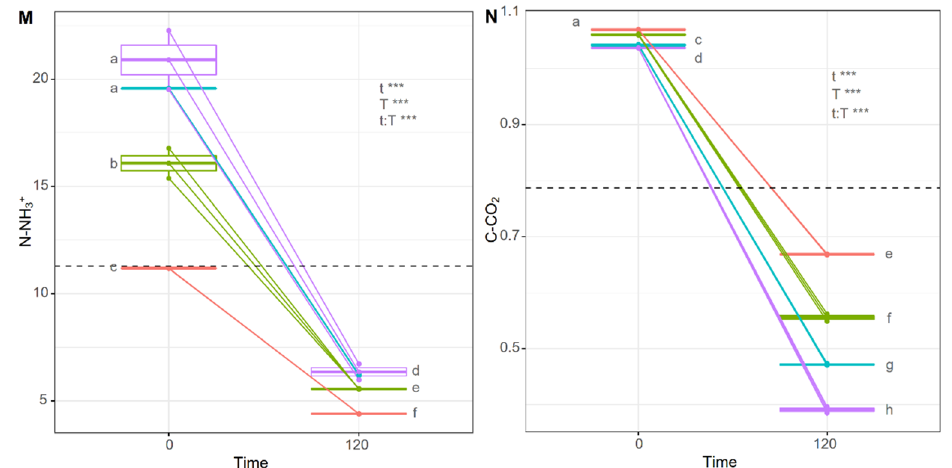
Figure 1. Two-way ANOVA of composting systems during C and N mineralization dynamics. Different letters indicate significant differences according to the two-way ANOVA with subsequent Tukey’s test of means at a significance level p ≤ 0.05. Time (days); T, treatment (T1, red line; T2, green line; T3, blue line; T4, purple line). ( A ) T , temperature (°C); ( B ) M, moisture (%); ( C ) pH, hydrogen potential; ( D ) EC, electrical conductivity (dS m − 1 ); ( E ) BD, bulk density (g cm − 3 ); ( F ) WHC, water holding capacity (%); ( G ) N-NO 2 − , nitrite (mg N-NO 2 − kg − 1 dry compost); ( H ) N-NO 3 − , nitrate (mg N-NO 3 − kg − 1 dry compost); ( I ) N-NH 4+ , ammonium (mg N-NH 4+ kg − 1 dry compost); ( J ) N min , mineralized N (mg N kg − 1 dry compost); ( K ) NI, nitrification index; ( L ) SOC, soluble organic C (mg SOC kg − 1 dry compost); ( M ) N-NH 3+ , ammonia (mg N-NH 3+ kg − 1 dry compost); ( N ) C-CO 2 , evolved C-dioxide (mg C-CO 2 kg − 1 dry compost). Vertical bars represent the standard deviation ( n = 5). Dotted line represents the mean of the indicator; ns, not significant; *, significant ( p ≤ 0.05 ) ; ***, highly significant ( p ≤ 0.001 )